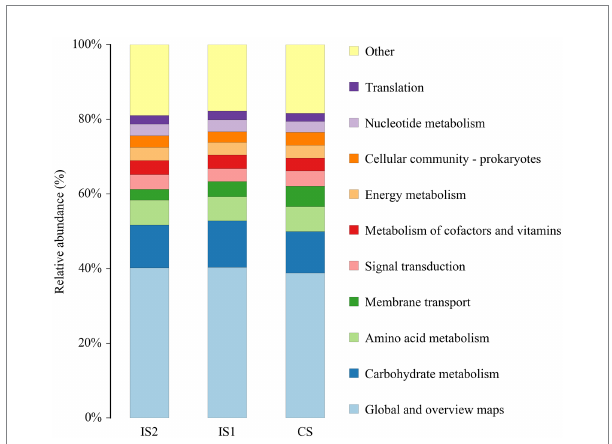
FIGURE 3 The top 10 annotated KEGG pathways (at level 2) across treatments based on Tax4Fun function prediction.